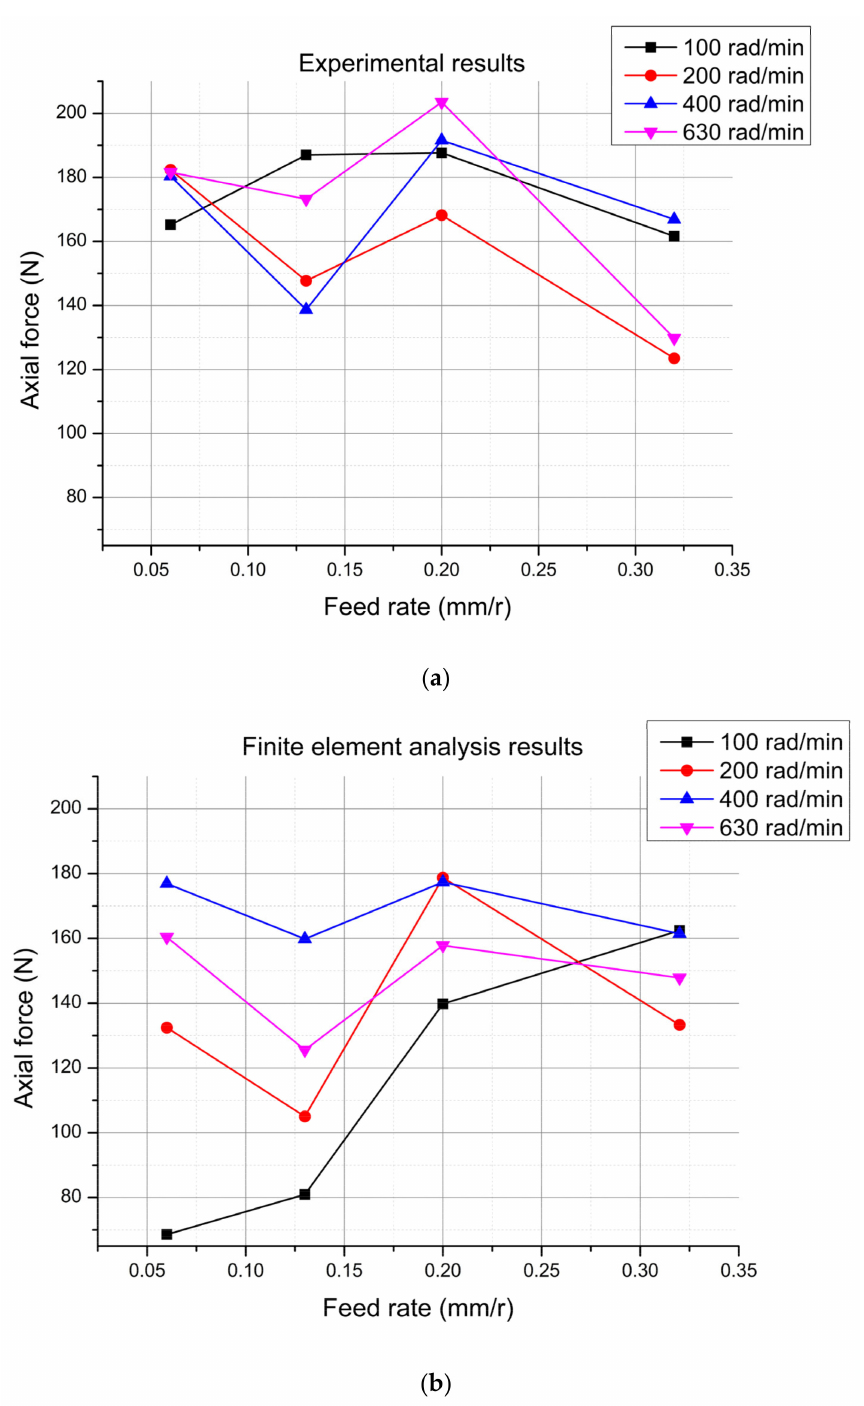
Figure 12. Experimental data 2 for sandstone. ( a ) During the testing process, the axial force changed with the change in feed rate at different rotational speeds. ( b ) Finite element analysis results corre- sponding to the test